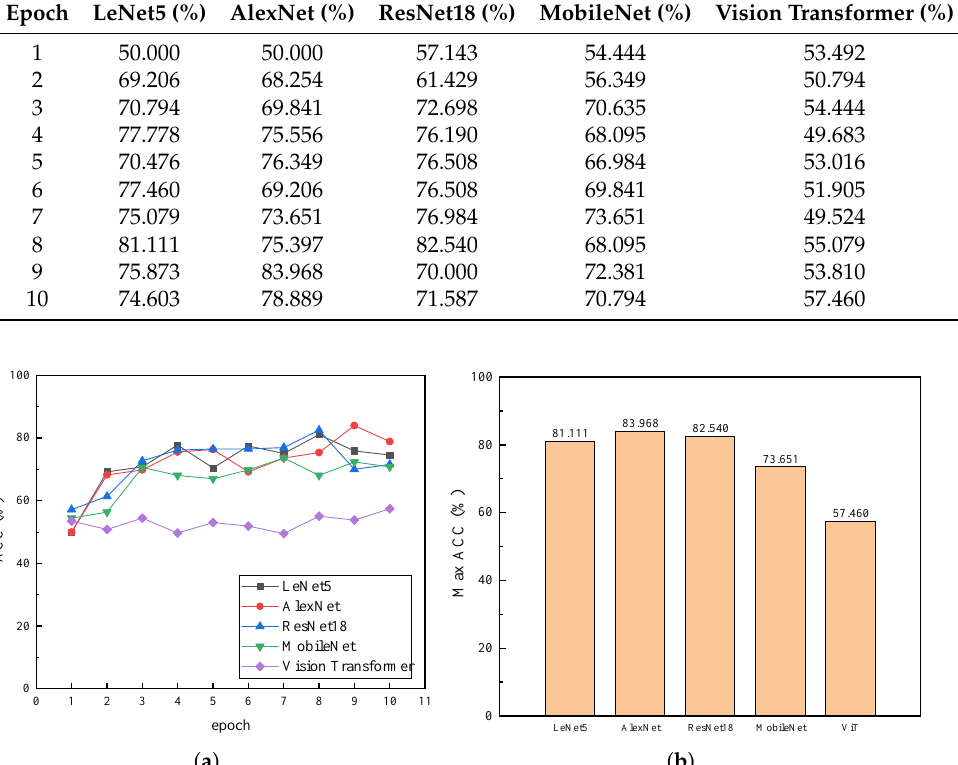
Figure 5. Comparison of accuracy before data augmentation and after GPU loading. ( a ) Comparison of accuracy of each model before data augmentation and after GPU loading. ( b ) Histogram comparing the highest accuracy of each model before data augmentation and after GPU